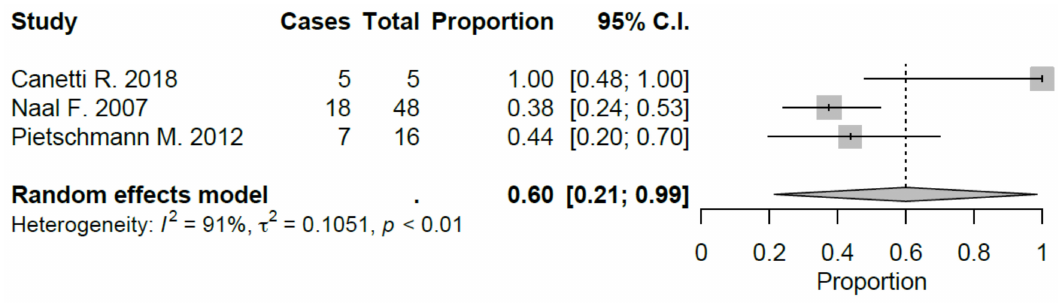
Figure 5. Return to swimming after UKA (C.I.: Confidence Intervals).